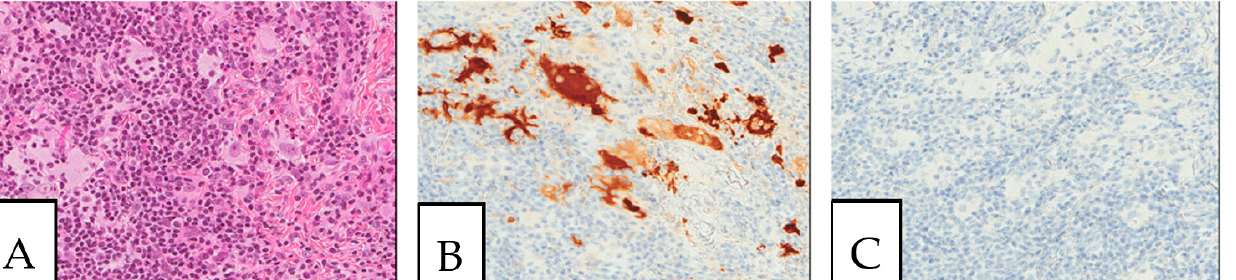
Figure 6. Rosai Dorfman disease. ( A ) . Cutaneous Rosai Dorfman disease showing histiocytes with an enlarged eosinophilic cytoplasm with engulfed inflammatory cells (emperipolesis). ( B ) . S100-positive lesional cells. ( C ) . CD1a-negative lesional cells. This biopsy was performed on a 64-year-old-female patient presenting with pigmented lesions of the back suspicious of regressive melanoma.